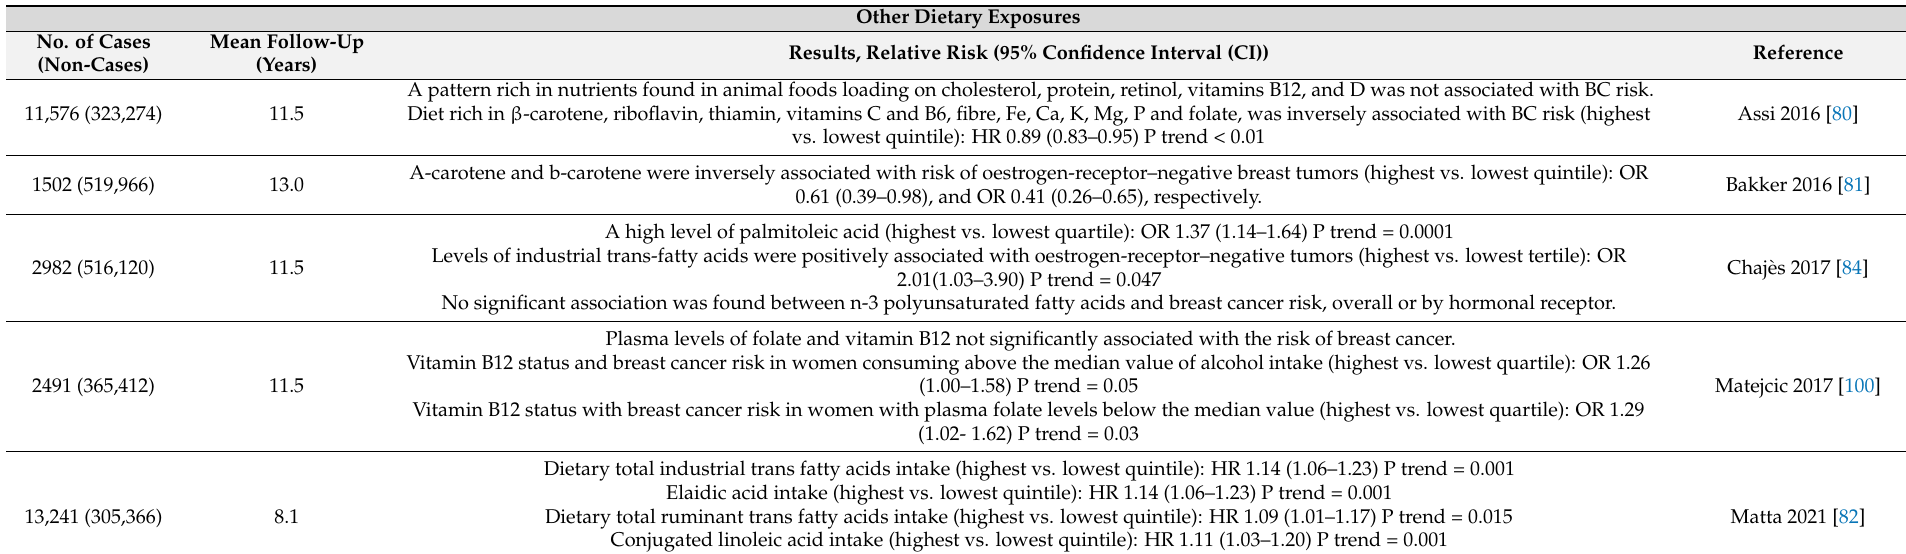
Table 2. Cont. Other Dietary Exposures